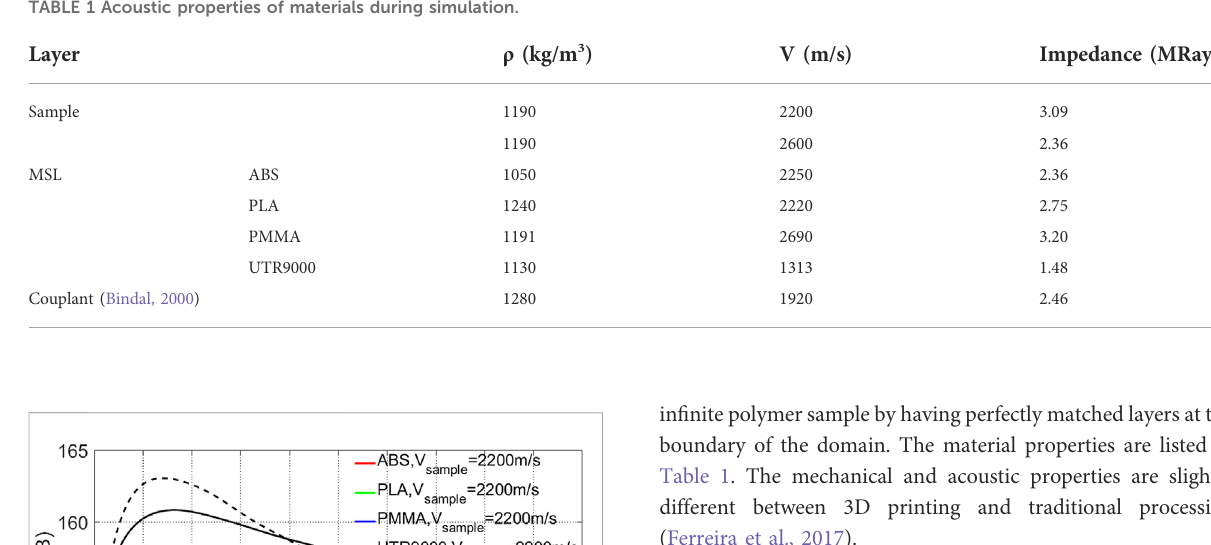
Table 1. The mechanical and acoustic properties are slightly different between 3D printing and traditional processing